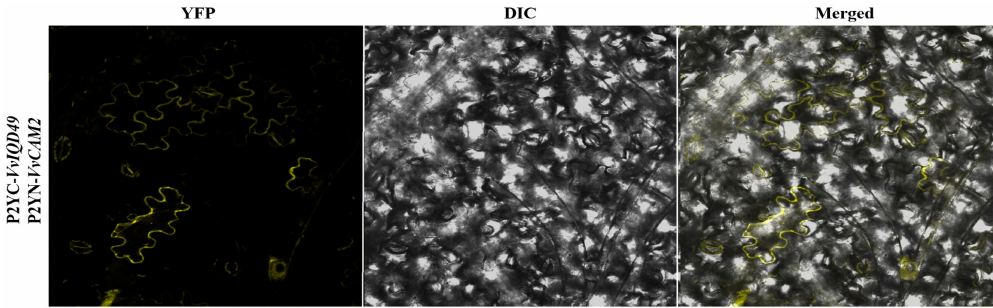
Figure 6. BiFC interaction analysis indicating VvIQD49 interaction with VvCaM2 by using the N. benthamiana epidermal